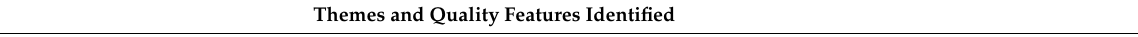
Table 1. Themes and quality features identified across all four dimensions in the systematic